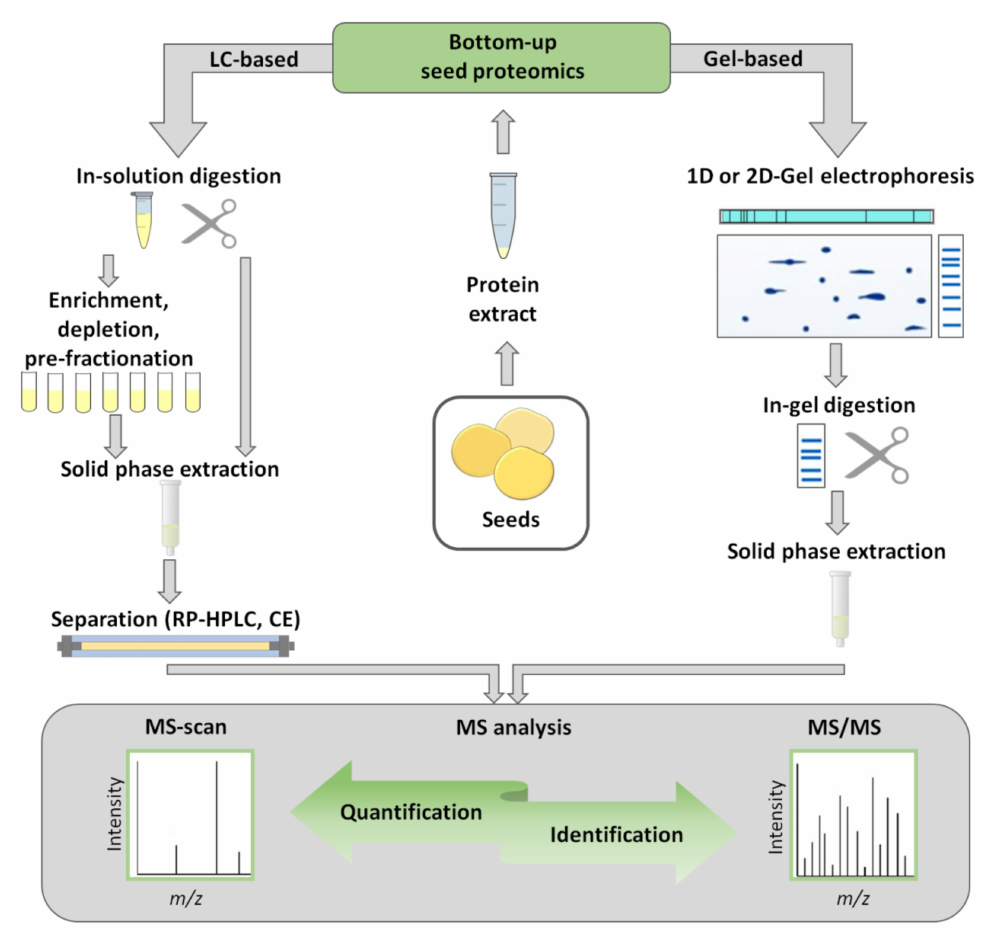
Figure 1. The overview of the experimental workflows for gel-based and gel-free